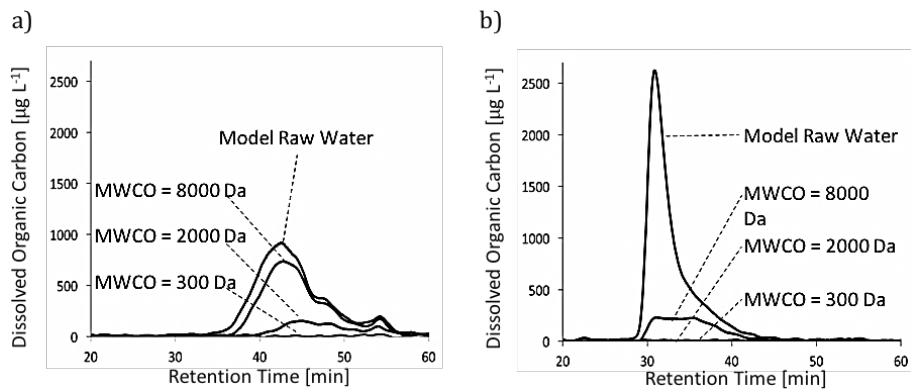
Figure 2. Typical size exclusion chromatograms of model raw water and permeate samples: ( a ) model raw water containing Suwannee River natural organic matter (SRNOM) at 10 mg/L; ( b ) model raw water containing alginate at 10 mg/L. Dalton values correspond to the molecular weight cut offs (MWCOs) of the different membranes; note that the retention time of the chromatograms is inversely proportional to the log of the molecular weight.